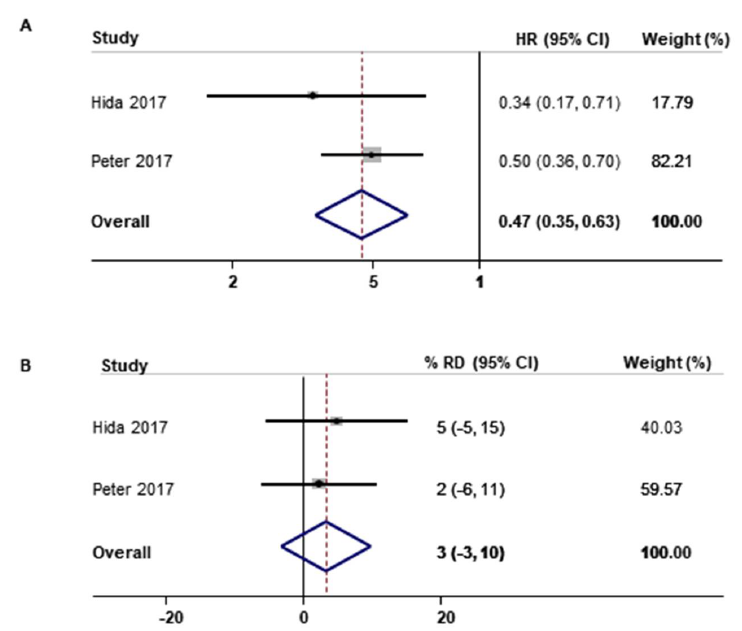
Figure 4. Efficacy of alectinib versus crizotinib in treatment of ALK-positive NSCLC by type of outcome. ( A ) progression-free survival, ( B ) overall survival rate; HR, hazard ratio, RD, rate difference, 95% CI, 95% confidence interval.